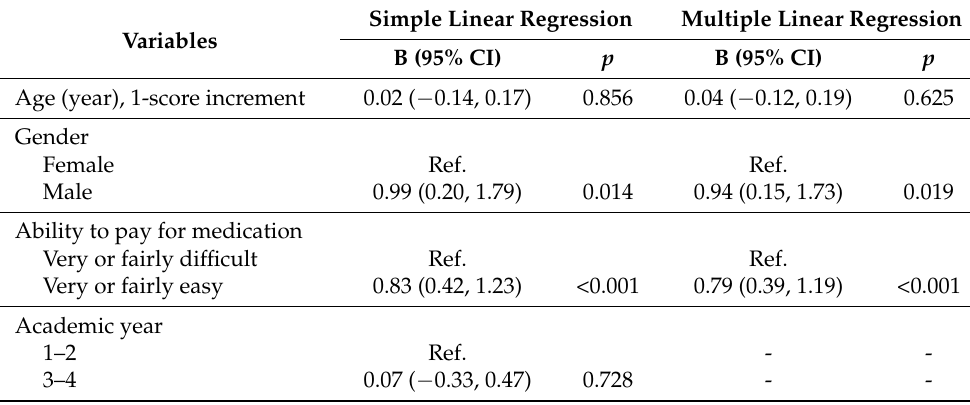
Table 3. Predictors of eHealth literacy among nursing students (n =